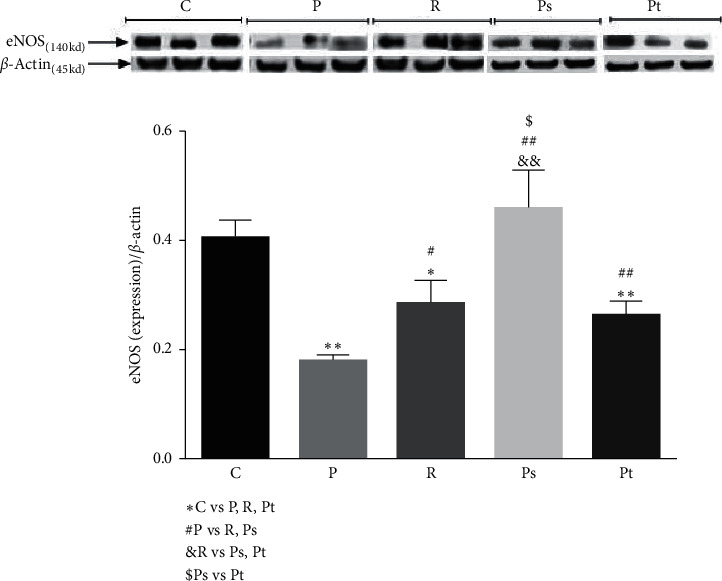
Response of eNOS in all patients regardless of gender. Levels of eNOS activity in the control group (C), primary pterygium (P), recurrent pterygium (R), and primary pterygium with systemic (Ps) or topical (Pt) pretreatment in all patients regardless of gender. ∗p < 0.05 and ∗∗p < 0.01 compared with group C. #p < 0.05 and ##p < 0.01 compared with primary pterygium group. &p < 0.05 and &&p < 0.01 compared with group R. $p < 0.05 compared groups with treatments.